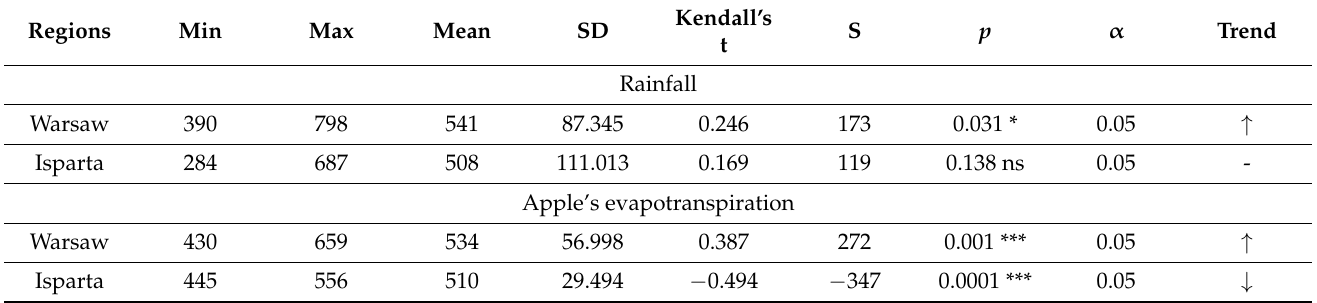
Figure 3. The change in the evapotranspiration of apples between 1984 and 2021 in Warsaw and Isparta. Table 4. Trend changes of ET and rainfall.